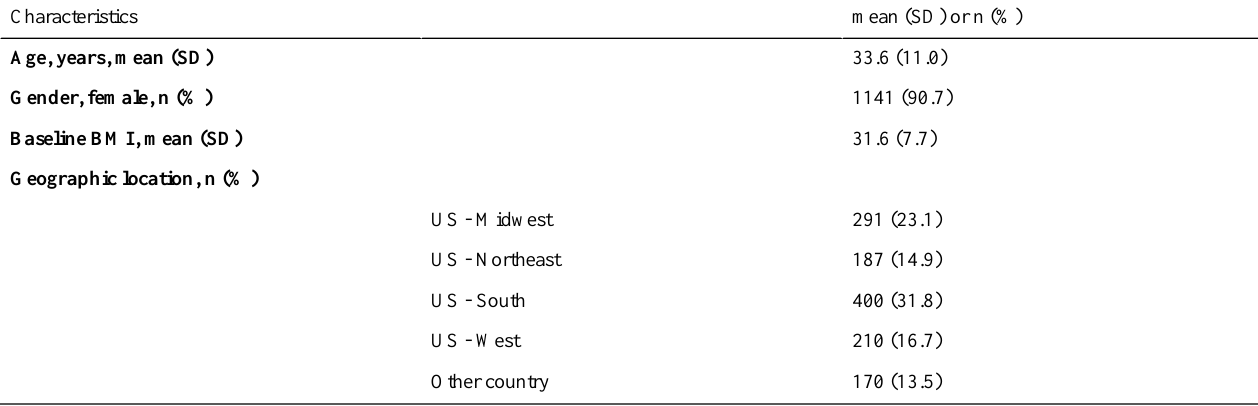
Table 1. Demographic characteristics of final cohort (n=1258).